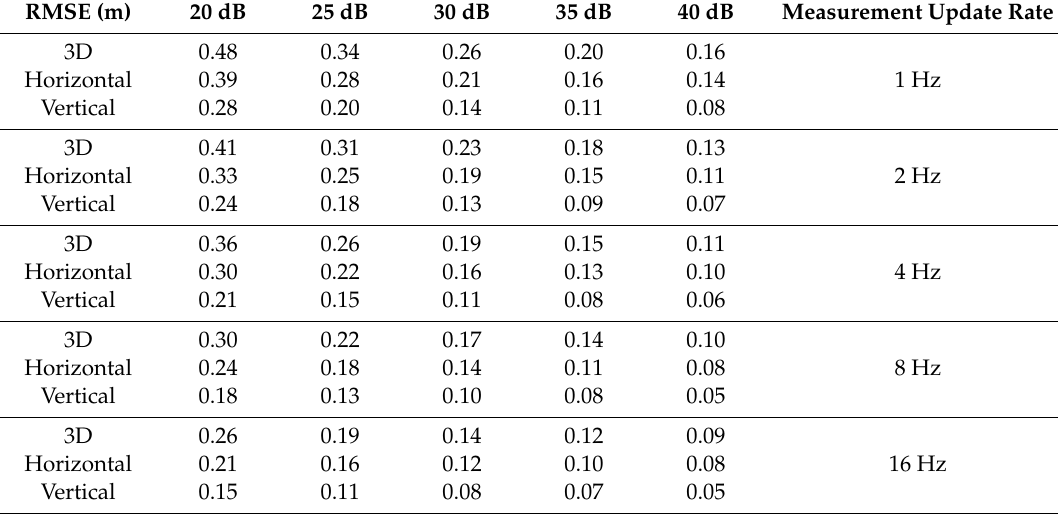
Figure 9. RMSE results along the horizontal circular path at a measurement update rate of 1 Hz.